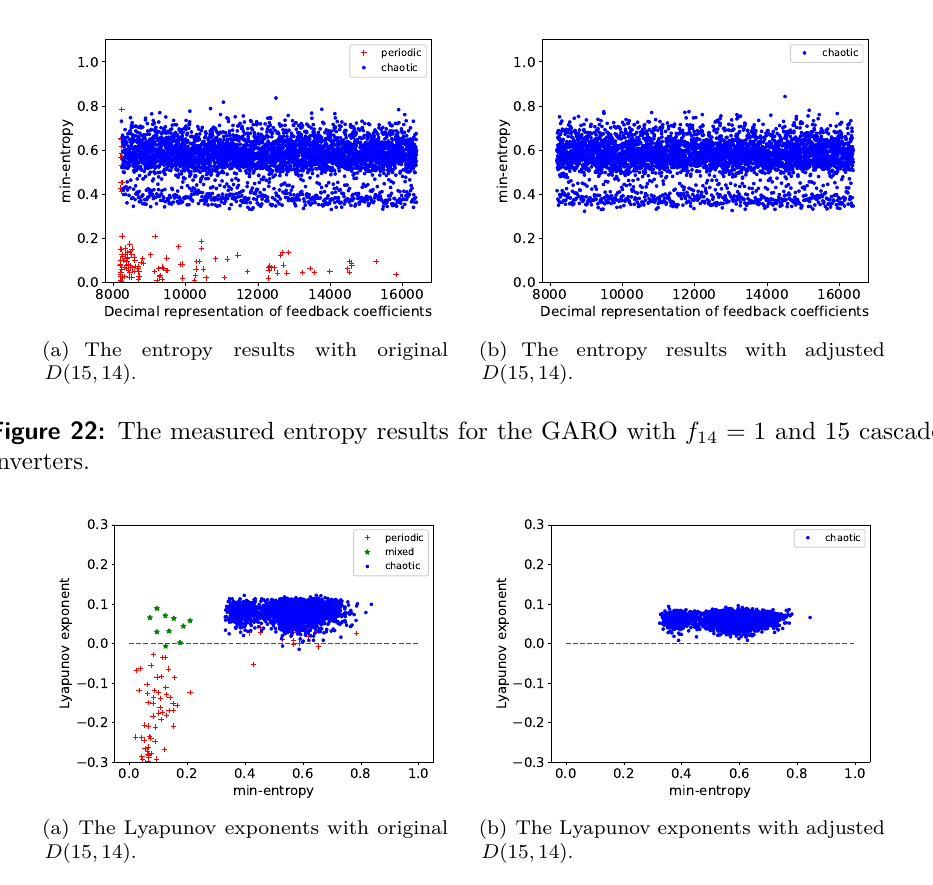
Figure 23: The measured Lyapunov exponents for the GARO with f 14 = 1 and 15 cascaded